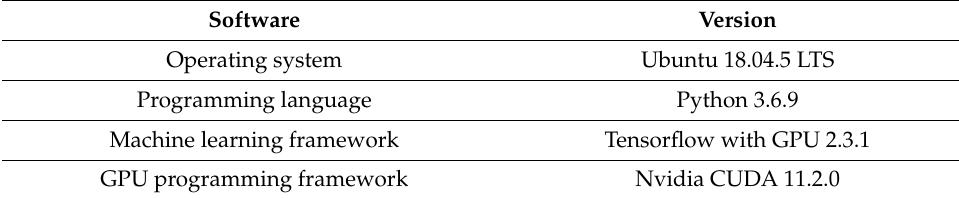
Table 5. The software